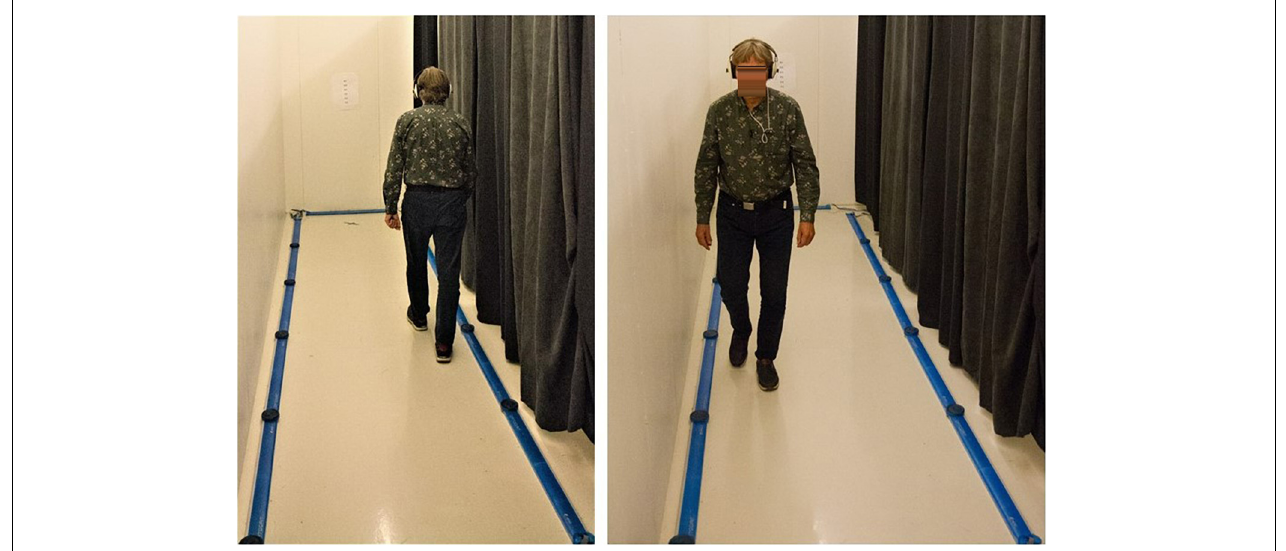
FIGURE 1 | Illustration of the dual-task experimental setting and a volunteer performing the paradigm.